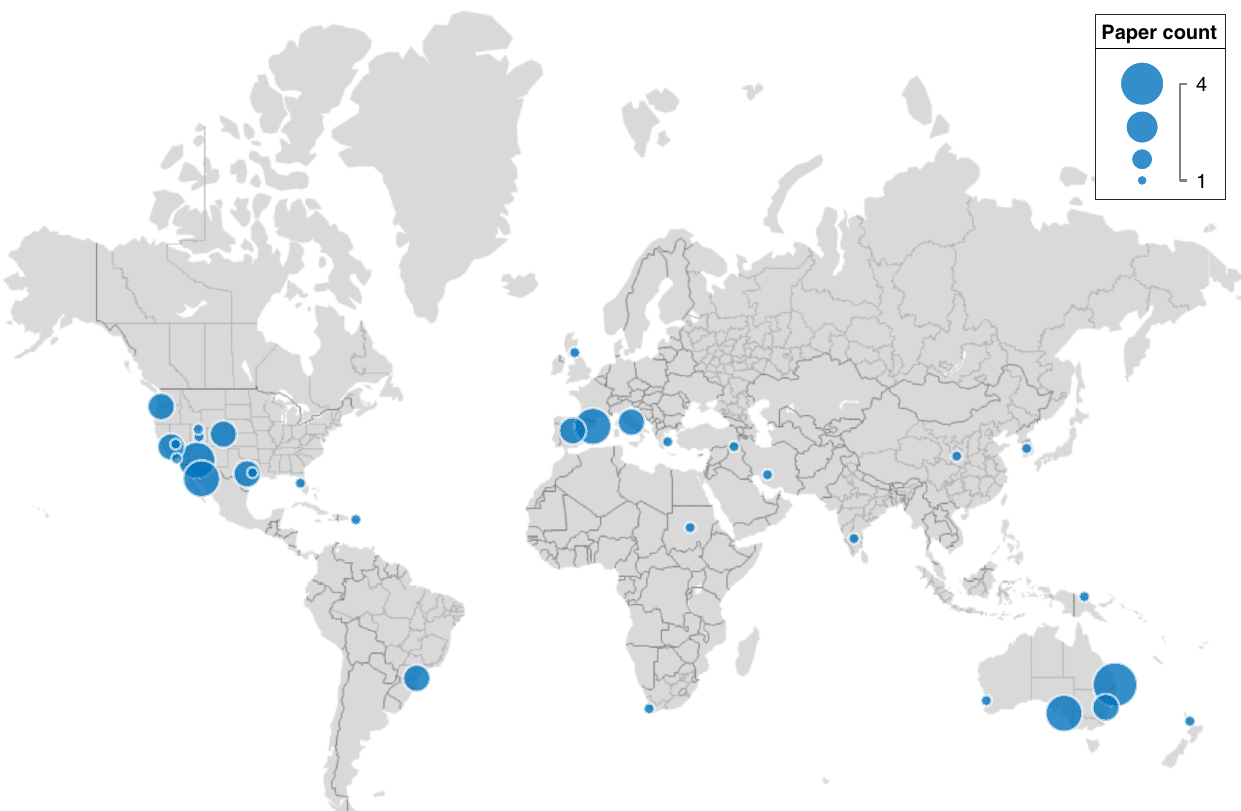
Fig. 4 Geographical locations of the 48 framework analysis papers. The location of the 48 framework analysis papers reviewed in this study is represented with blue markers. Marker size is proportional to the amount of studies in a speci fi c